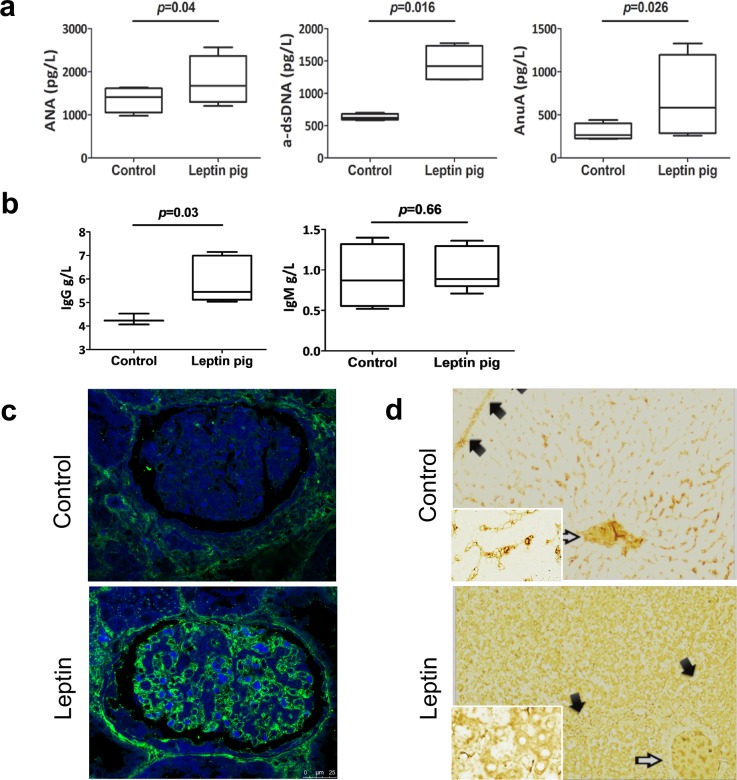
Autoantibody examination and Ig deposition detection for characterization of SLE.(a) ANA, α-dsDNA, and ANuA concentrations in serum were analyzed by ELISA (n = 6 per group). (b) The levels of IgG and IgM were detected (n = 6 per group). (c) Sections of the kidney (original magnification, 400×) and (d) liver (original magnification, 100×) were analyzed by immunofluorescence (IgG [green] deposition and DAPI [blue]) or IHC (IgG [brown]) to reveal the IgG deposition. p < 0.05 shows significance difference, two-tailed Student t test for a,b. Data are presented as mean ± SEM. Numerical values are provided in S1 Data. ANA, antinuclear antibody; ANuA, antinucleosome antibody; α-dsDNA, anti-dsDNA; dsDNA, double-stranded DNA antibody; Ig, immunoglobulin; IHC, immunohistochemistry; SLE, systemic lupus erythematosus.